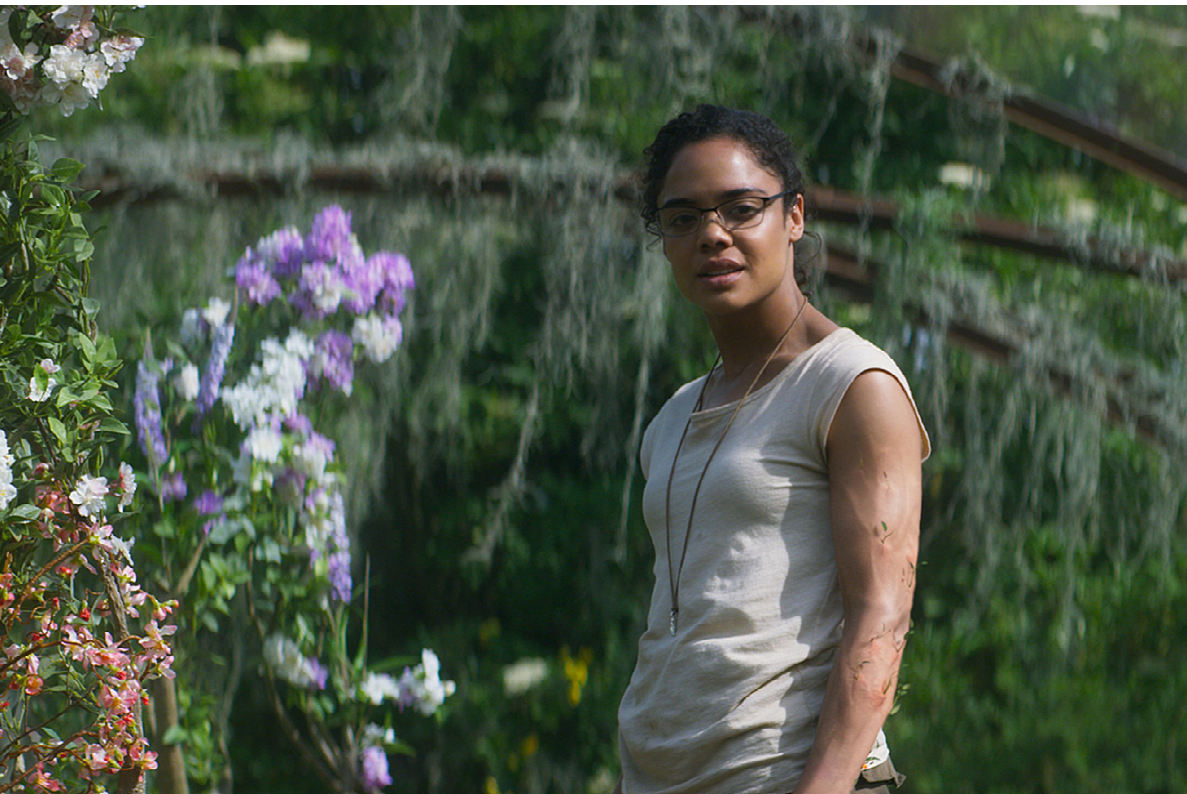
Figure 6. Flowers sprouting on Josie Radek’s arm, film still from Annihilation (Alex Garland, 2018) (© Netflix).